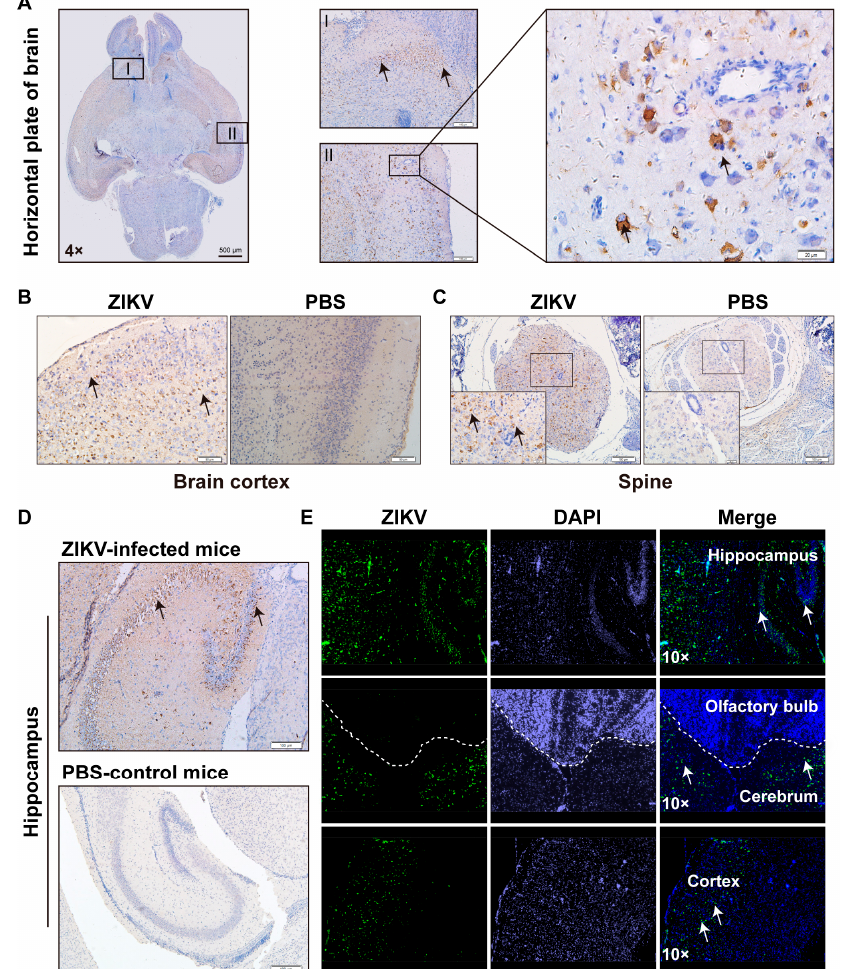
Figure 5. ZIKV infected multiple areas of CNS. ( A ) Horizontal section of the brain of the ZIKV-infected mouse was stained with anti-E protein. The area I and II was amplified to show the infection of ZIKV (brown color stand for the positive infection; ( B – D ) Immunohistochemistry (IHC) analysis of CNS tissues after being infected with PRVABC59. The 1-day-old C57BL/6 mice were infected i.p. with 10 6 TCID 50 PRVABC59 per mouse or PBS. Mice were sacrificed at 11 dpi to isolate brain tissue for sectioning and staining by the IHC method. Representative pictures from PRVABC59-infected brain tissue slides were selected to show ( B ) brain cortex; ( C ) spine; ( D ) hippocampus; ( E ) the same as in ( B – D ) but stained with IFA for hippocampus, olfactory bulb, cerebrum, and cortex. Scale bars: A left 500 m, A middle, 100 m, A right, 20 m; B 50 m; C 100 m; D 100 m.